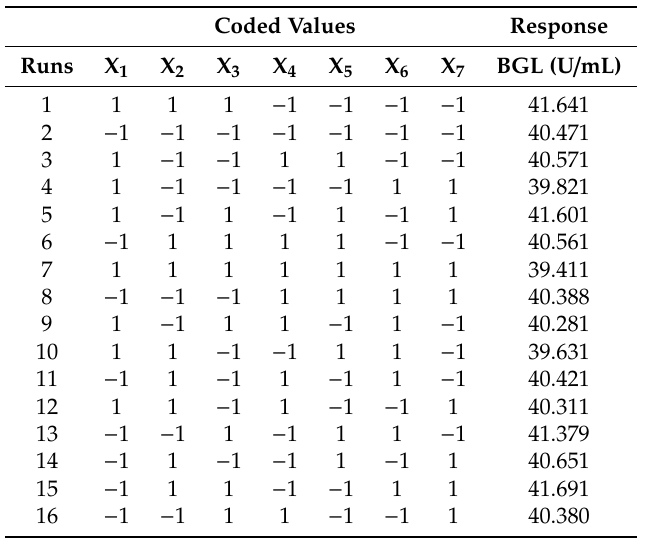
Table 3. Fractional Factorial Design. Multiple screening designs for identification of the most influential factors on the production of S.griseus recombinant β -glucosidase. It depicts coded values of the designs, along with the observed experimental response ( β -glucosidase activity (BGL); U / mL).